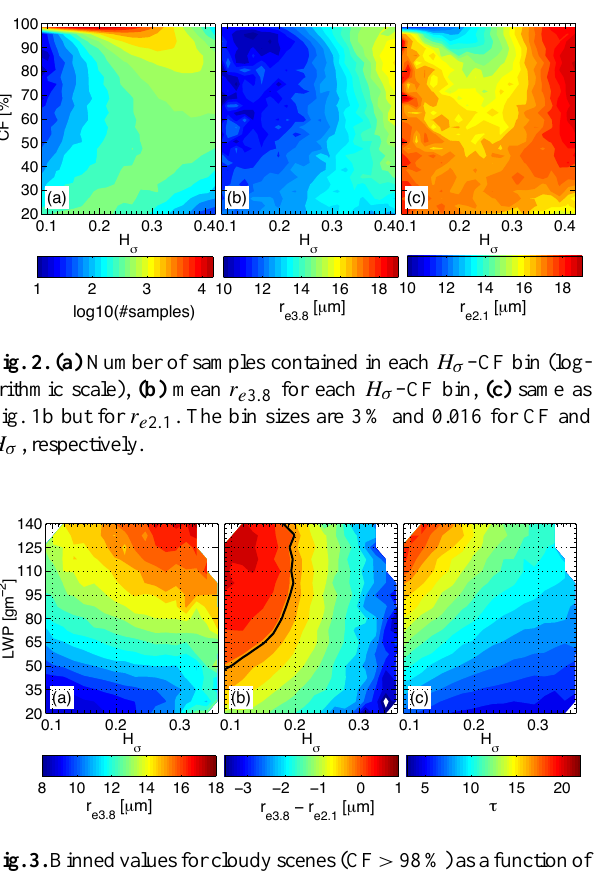
1.4 gm − 2 for LWP 3 . 8 and LWP 2 . 1 , respectively. Interestingly, the differences between Fig. 4a and b are accompanied by contrasting changes in H σ (Fig. 4c). Coastal and offshore re- gions yield distinctive values of H σ , with a distribution mode of 0.15 for coastal clouds (Fig. 4c, gray line), and 0.25 for far offshore clouds (black line). The MODIS LWP and H σ relationship is further emphasized in Fig. 4d, where mean H σ values and the mean differences between LWP 3 . 8 and LWP 2 . 1 are shown as a function of longitude. The LWP 3 . 8 – LWP 2 . 1 zonal gradients are concomitant with H σ increases, indicating a distinctive bias compensation between both r e values and τ to changes in heterogeneities. We explore this idea in more detail by taking averages of all the binned MODIS variables over the study region (constructed from LWP AMSR-E ) as a function of H σ bins. The results in Fig. 5a reveal a close match between r e 2 . 1 and r e 3 . 8 for homogeneous cases and a greater increase of r e 2 . 1 with H σ (black and red lines). The decreases in MODIS LWP with H σ in Fig. 5b are more dramatic for LWP 3 . 8 . Here, the AMSR-E LWP is constant at 80 g m − 2 by